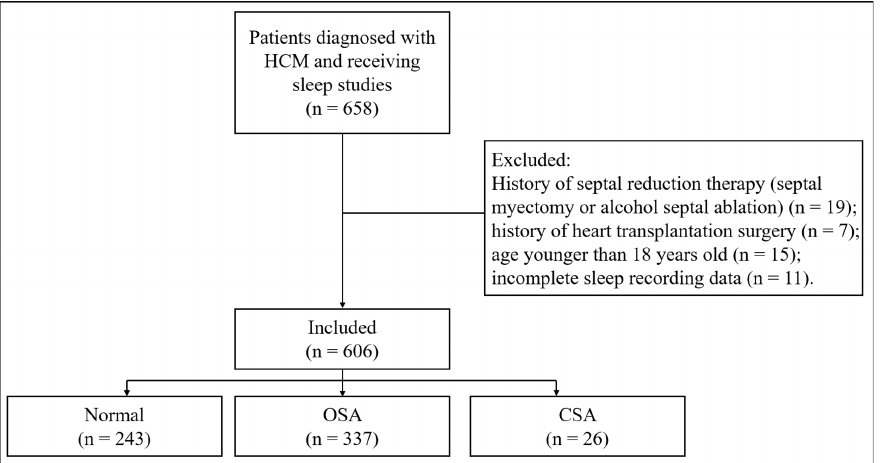
Figure 1. The study flowchart. HCM: hypertrophic cardiomyopathy; OSA: obstructive sleep apnea; CSA: central sleep apnea.